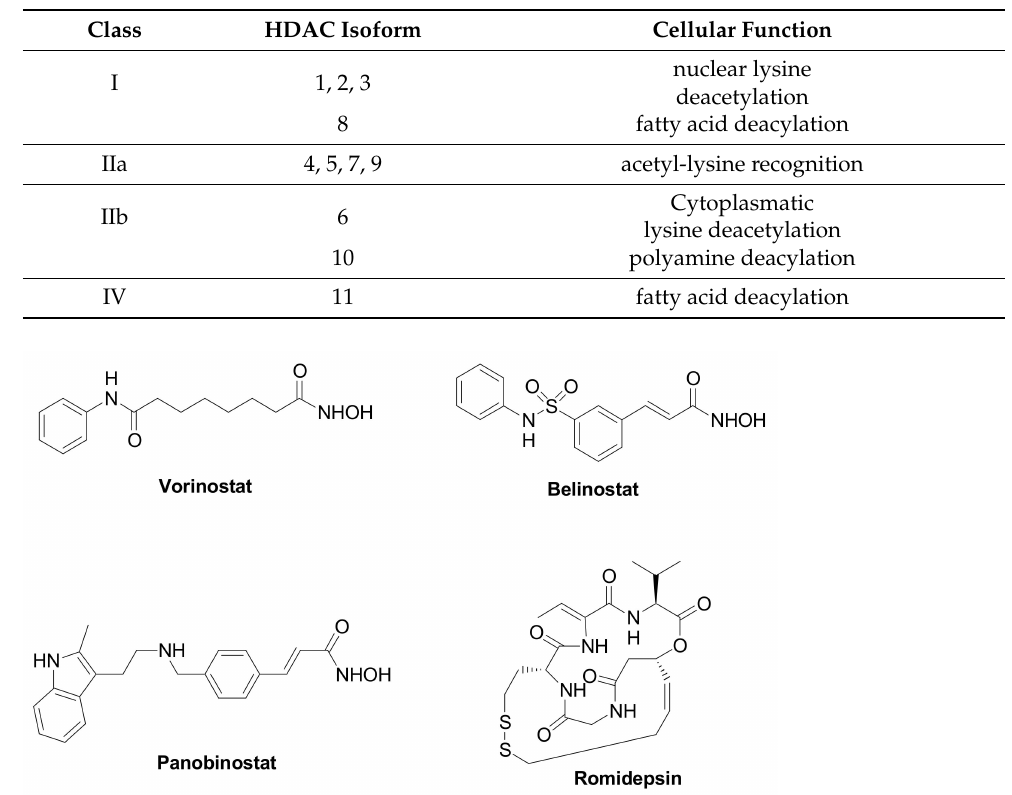
Table 1. Classification and cellular function of HDACIs.